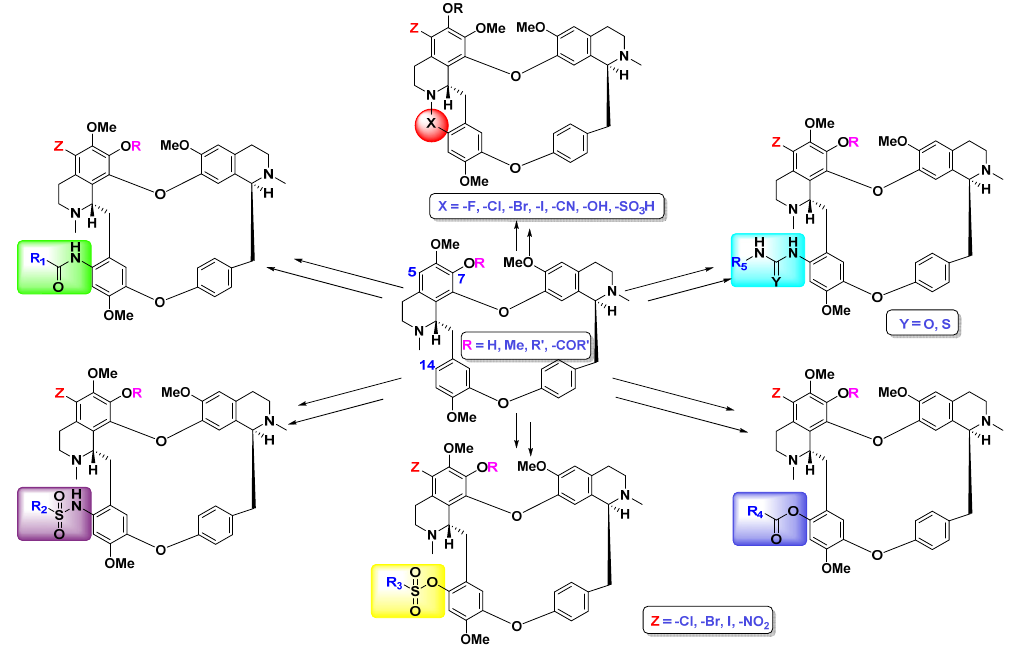
Scheme 1. Design and synthesis of investigated alkaloid analogues.